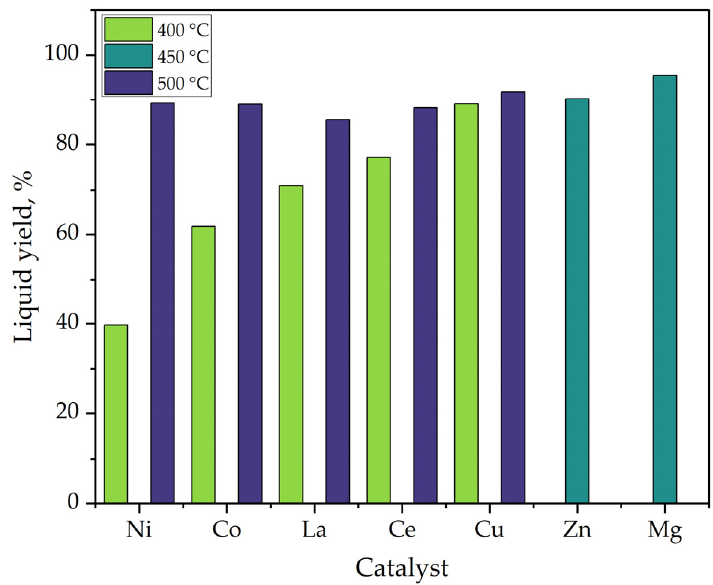
Figure 9. Liquid yield of different alumina-supported